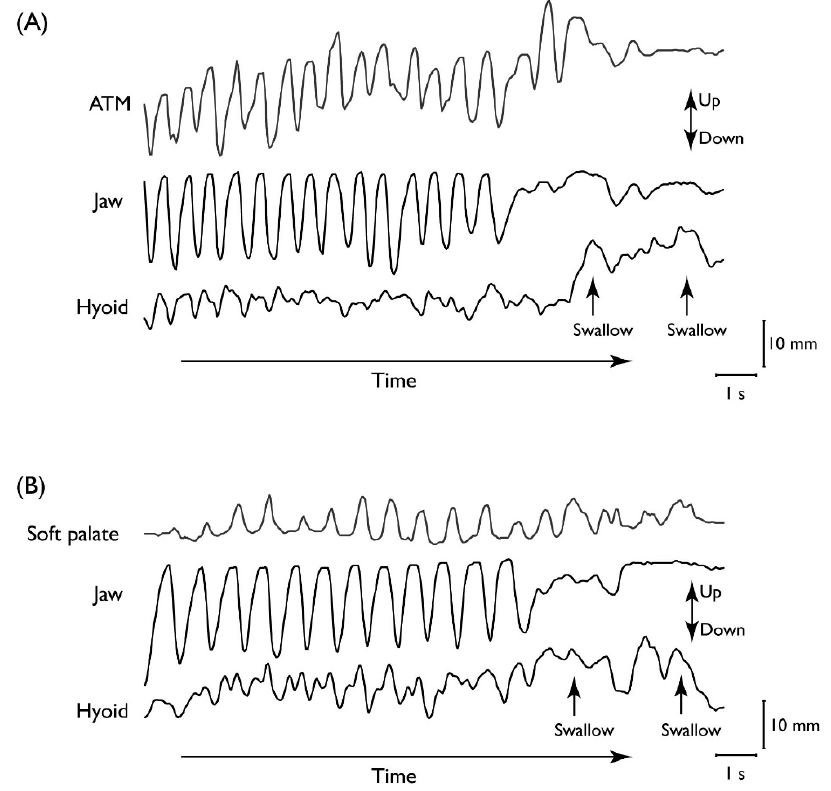
Figure 2. Movements of the jaw, hyoid, and ( A ) tongue or ( B ) soft palate over time. Vertical positions of ( A ) the anterior tongue marker (ATM), lower jaw, and hyoid bone, and ( B ) the soft palate, lower jaw, and hyoid bone in a complete feeding sequence. Movement towards the top of the figure is upwards. The positions of the structures are plotted relative to the upper jaw over time. Rhythmic movement of the tongue and soft palate is temporally linked to cyclic jaw movement.